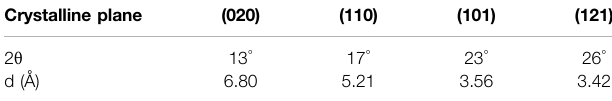
Frontiers in Materials |